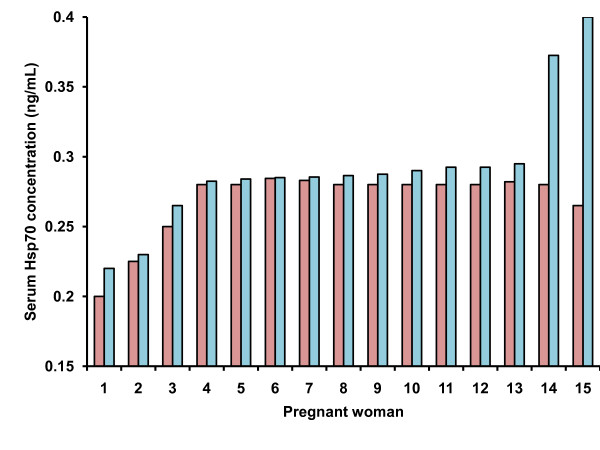
Concentration of HSP70 in serum. Concentration of HSP70 in serum of women using ELISA at the third trimester of pregnancy (3TP, pink bars) and the same women at the active labor phase (ActLP, blue bars).